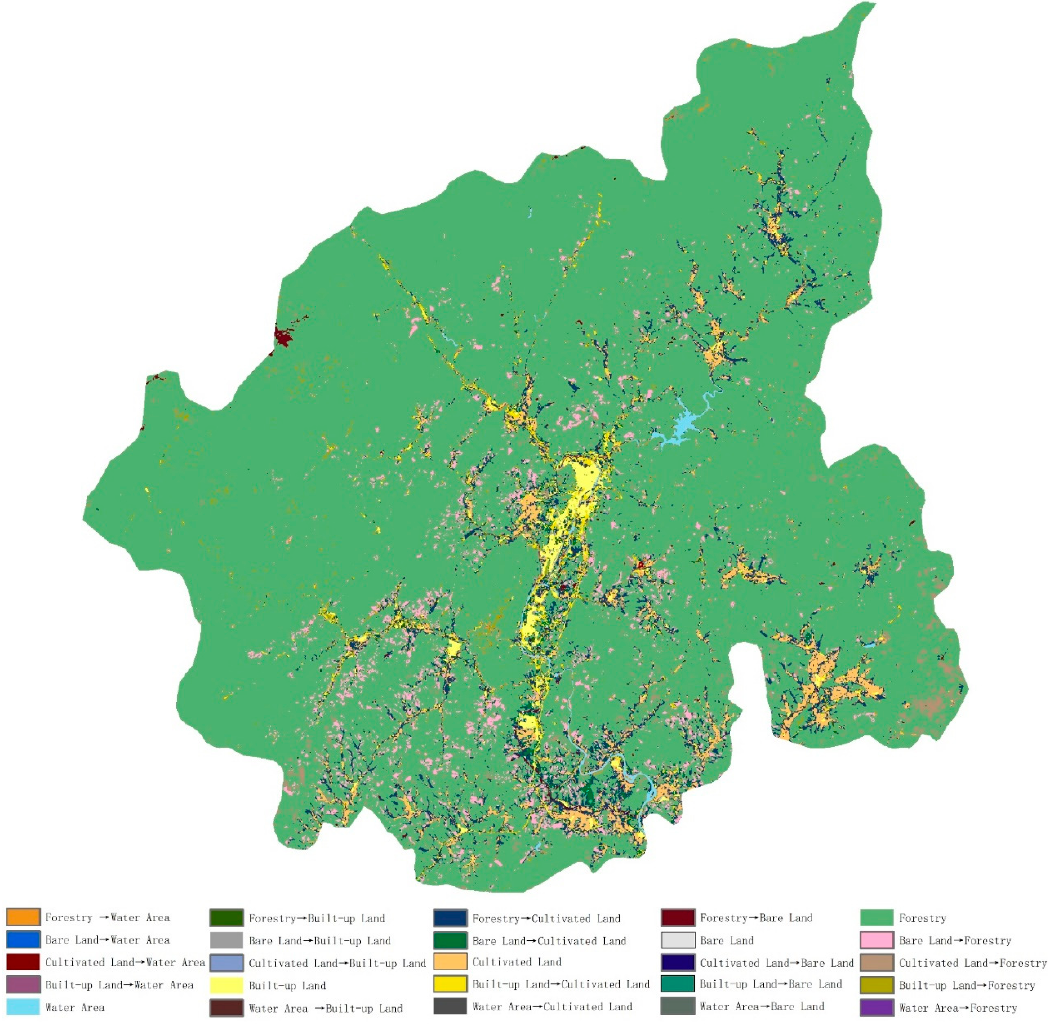
Figure 2. Land use change of 2014–2017.